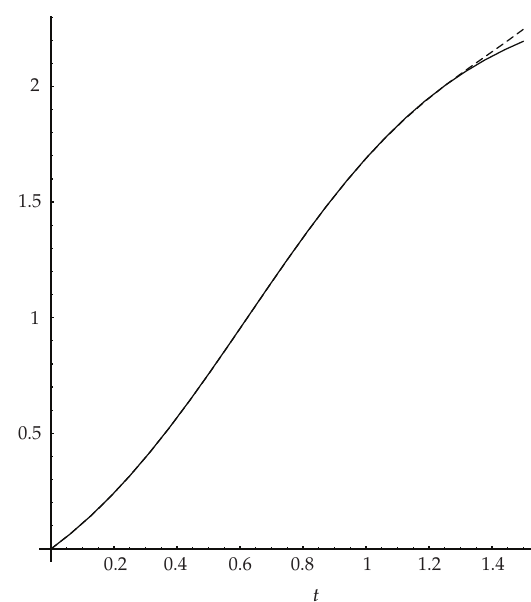
Figure 3: Dashed line: Approximate